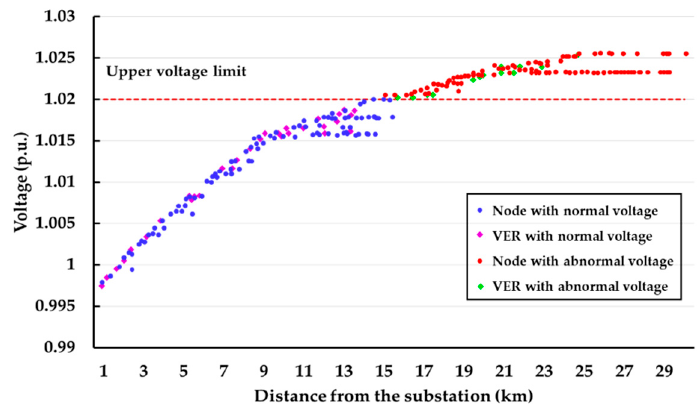
Figure 3. Voltage profile on one of the feeders in the Korea distribution system.